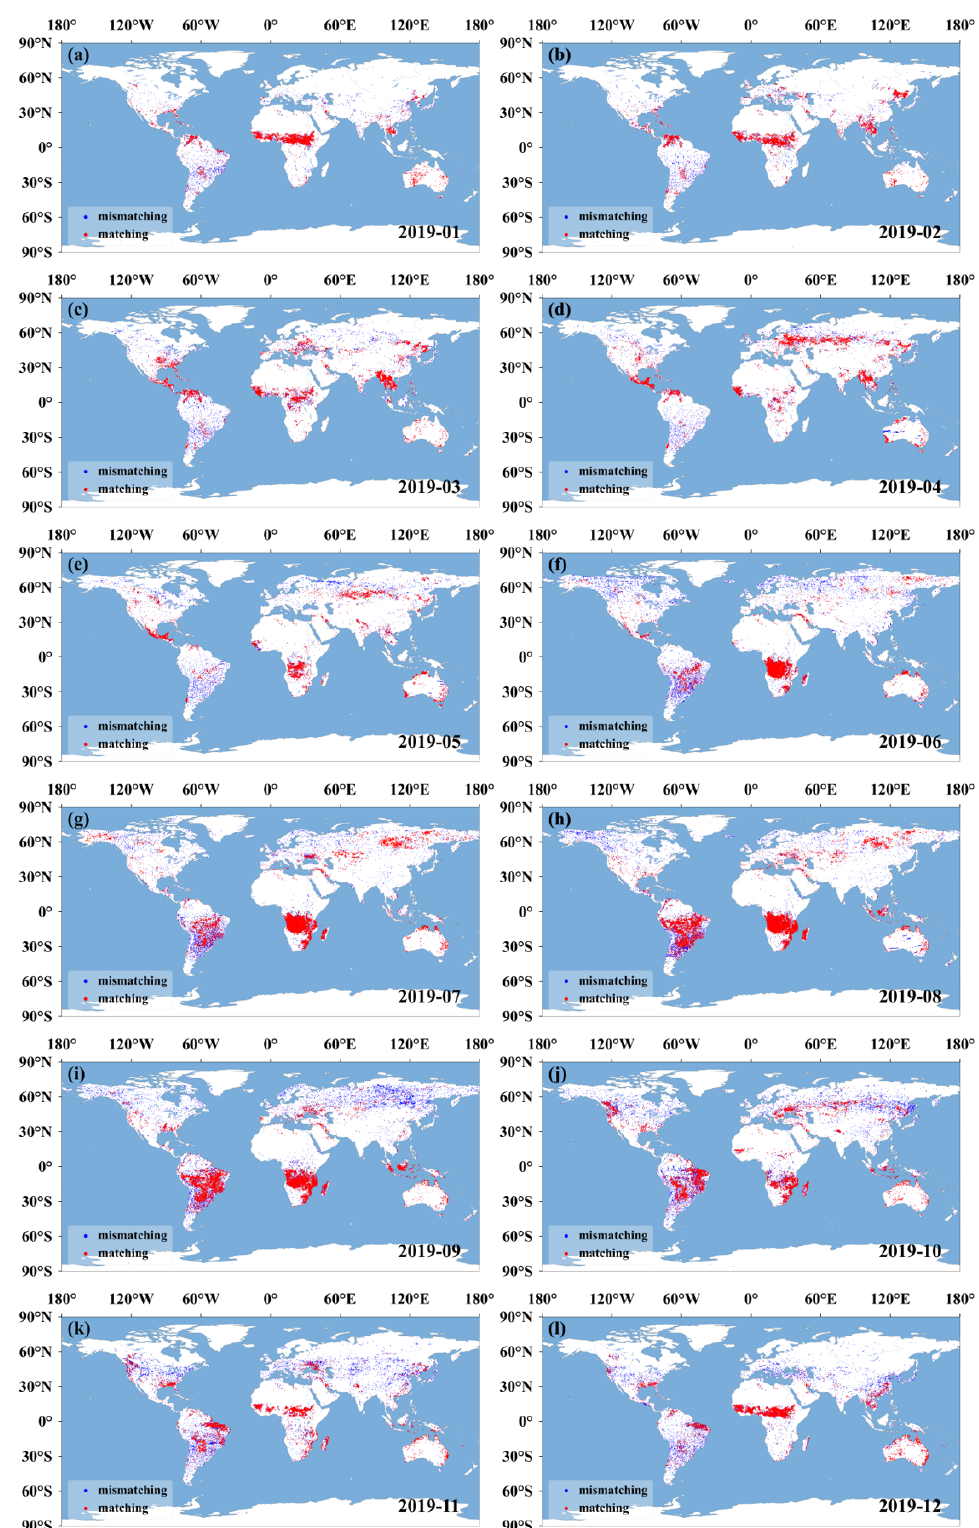
Figure 6. The consistence between FY-3D and MODIS fire products in different months (2019).